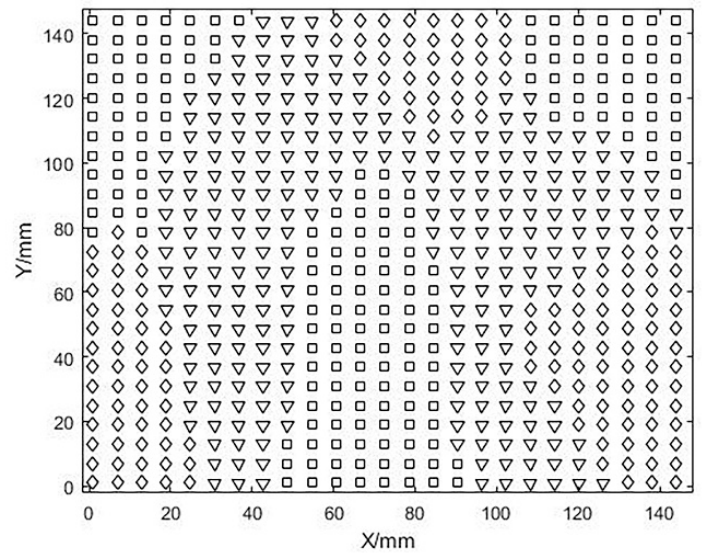
Figure 7. Preliminary division of the surface based on curvature, □ stands for convex area, ▽